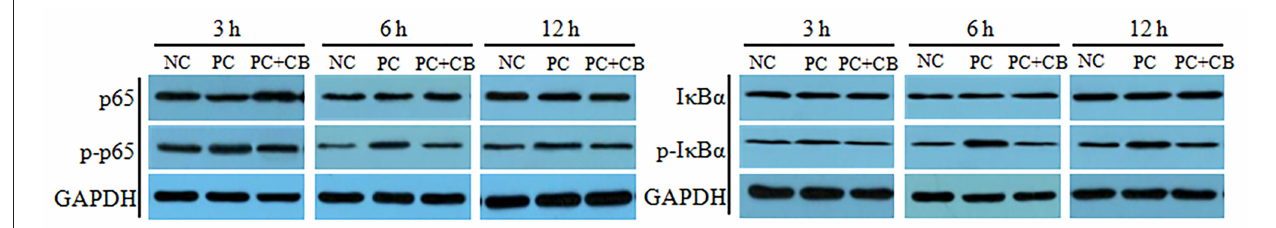
FIGURE 1 | Effect of CB on the activation of NF- κ B p65 and I κ B α in ETEC K88-infected piglets. Pigs were challenged with or without ETEC (1 × 10 9 CFU/kg BW). At 3, 6, and 12h post inflammatory challenge, intestinal mucosa samples were collected to examine the expression of p65, p-p65, I κ B α , and p-I κ B α by Western blotting. NC, piglets were fed the daily diet and received oral administration of sterile physiological saline; PC, piglets were fed the daily diet and received oral challenge with ETEC K88; PC + CB, piglets were fed the CB-supplemented diet and received oral challenge with ETEC K88.